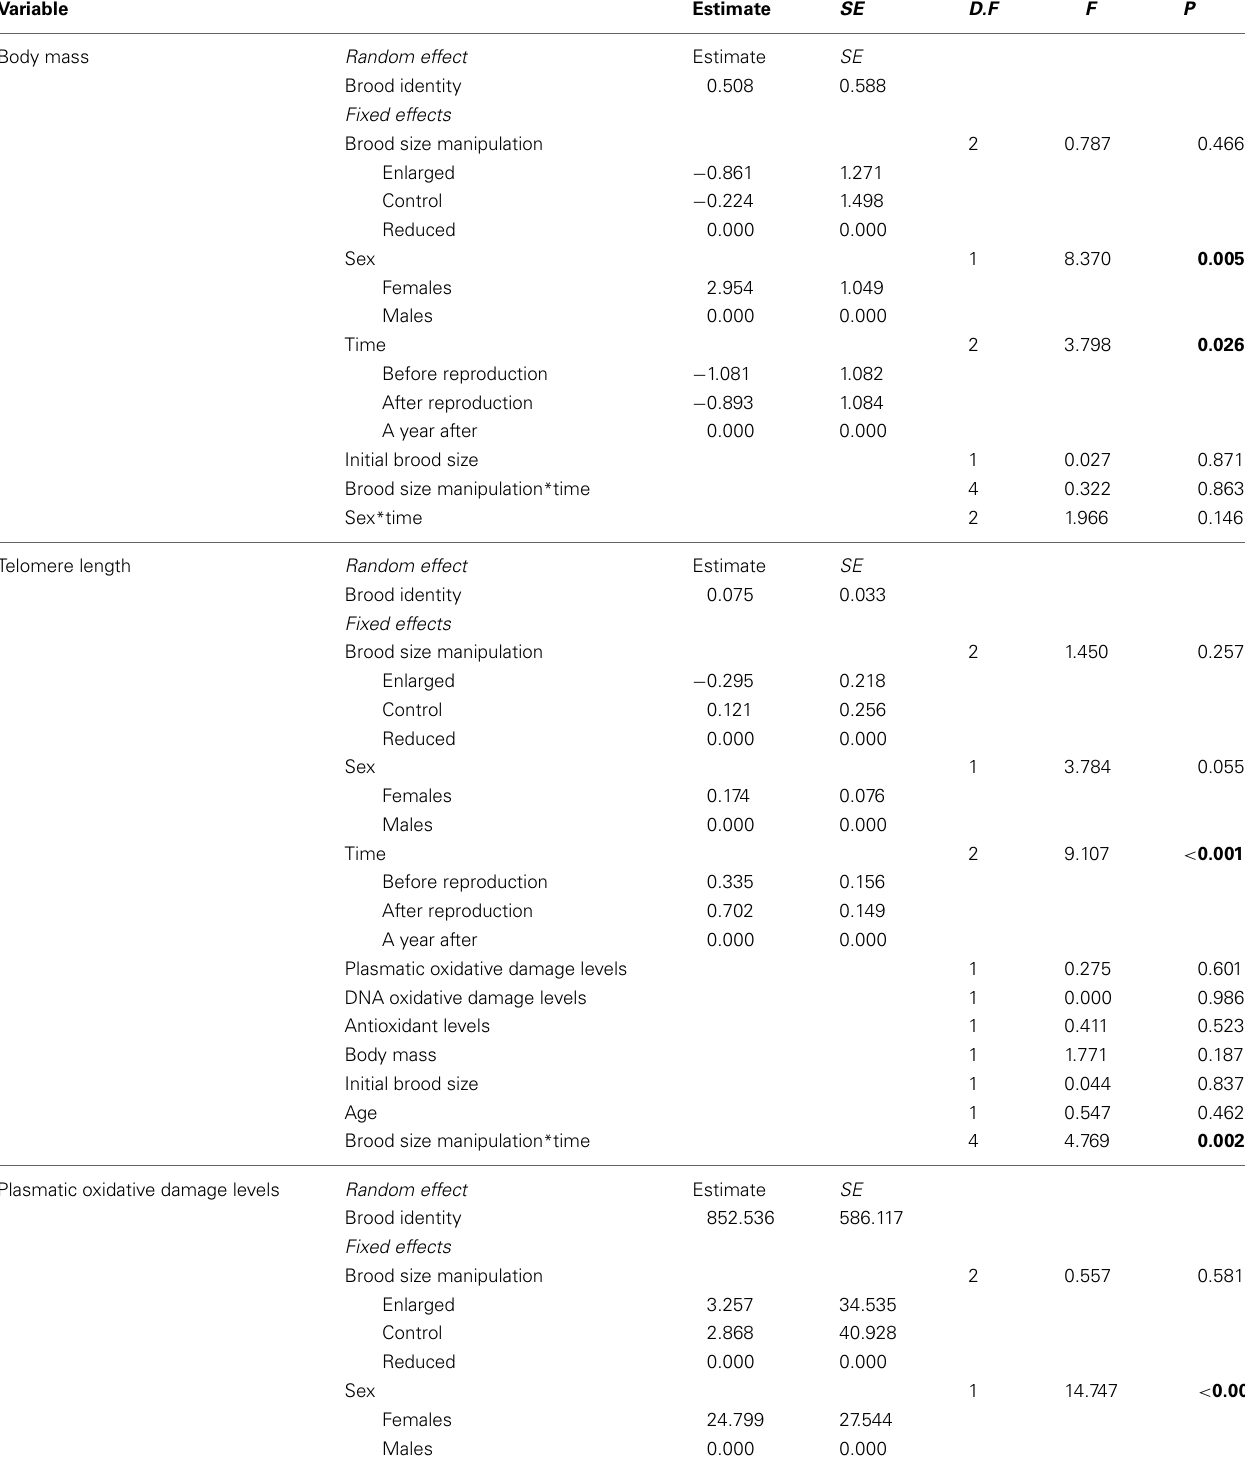
Table 1 | Results of linear mixed model on body mass, telomere length, oxidative damage levels (plasmatic measured asmg dl-1 H2O2 equivalents and DNA measured as 8-OHdG pg/ml), and antioxidant levels (measured as mmol-1 HOCl